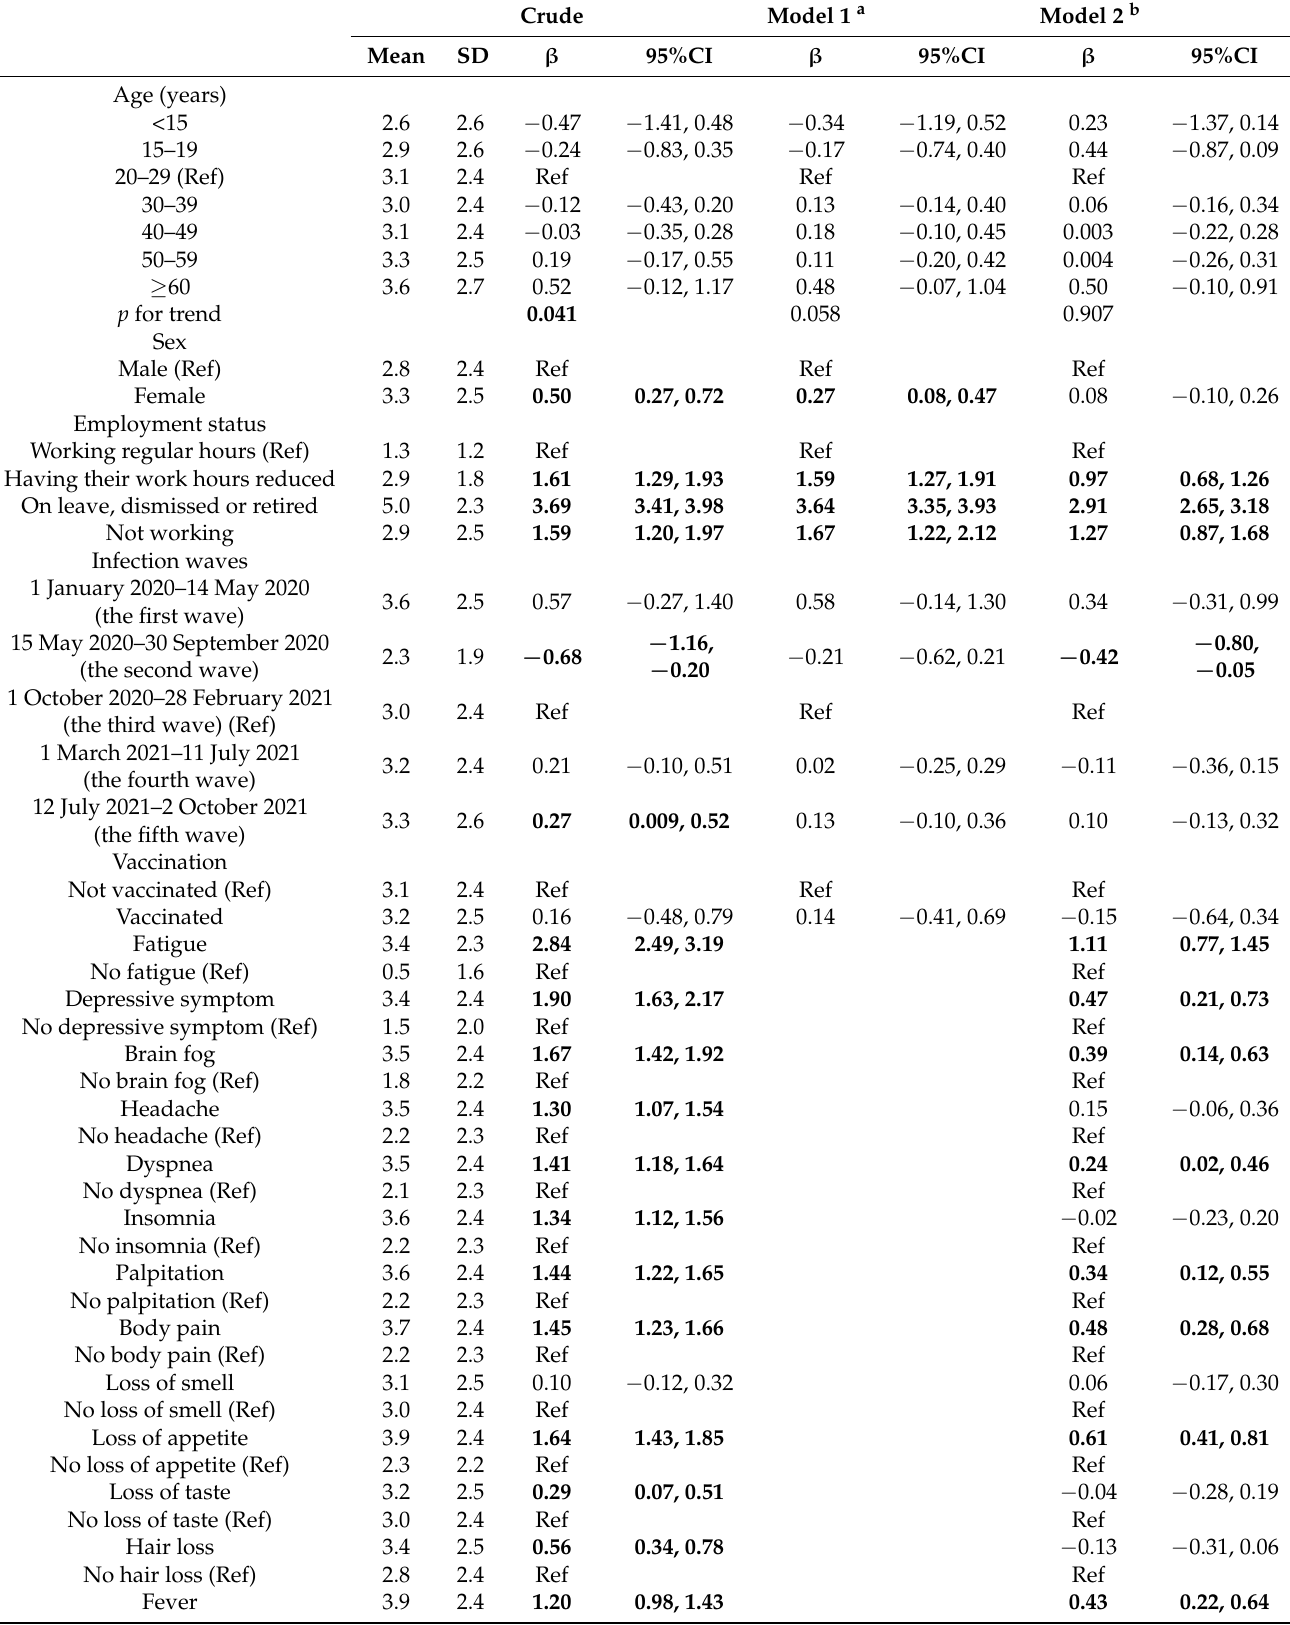
Table 2. Association between patients’ characteristics and performance status score ( n =